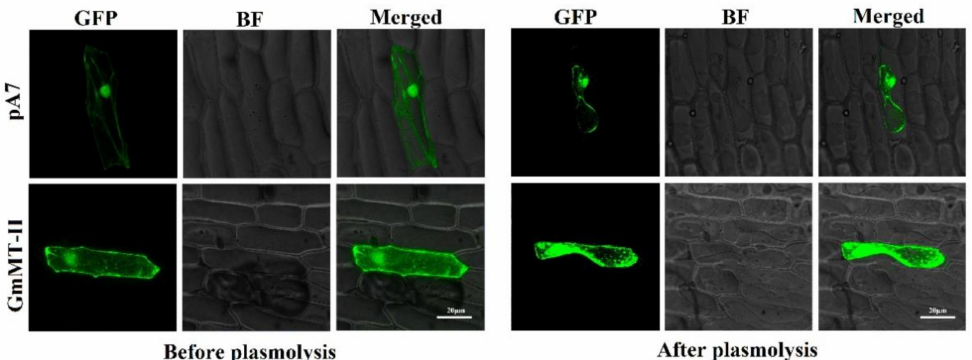
Figure 3. Subcellular localization of GmMT-II in onion epidermis. Confocal images showing the localization of GmMT-II in soybean mesophyll protoplasts and the empty vector (pA7) was used as negative control. The GFP signal was detected using confocal microscopy (GFP, green), bright field (gray), and merged signals are shown. Scale bars—20 µ